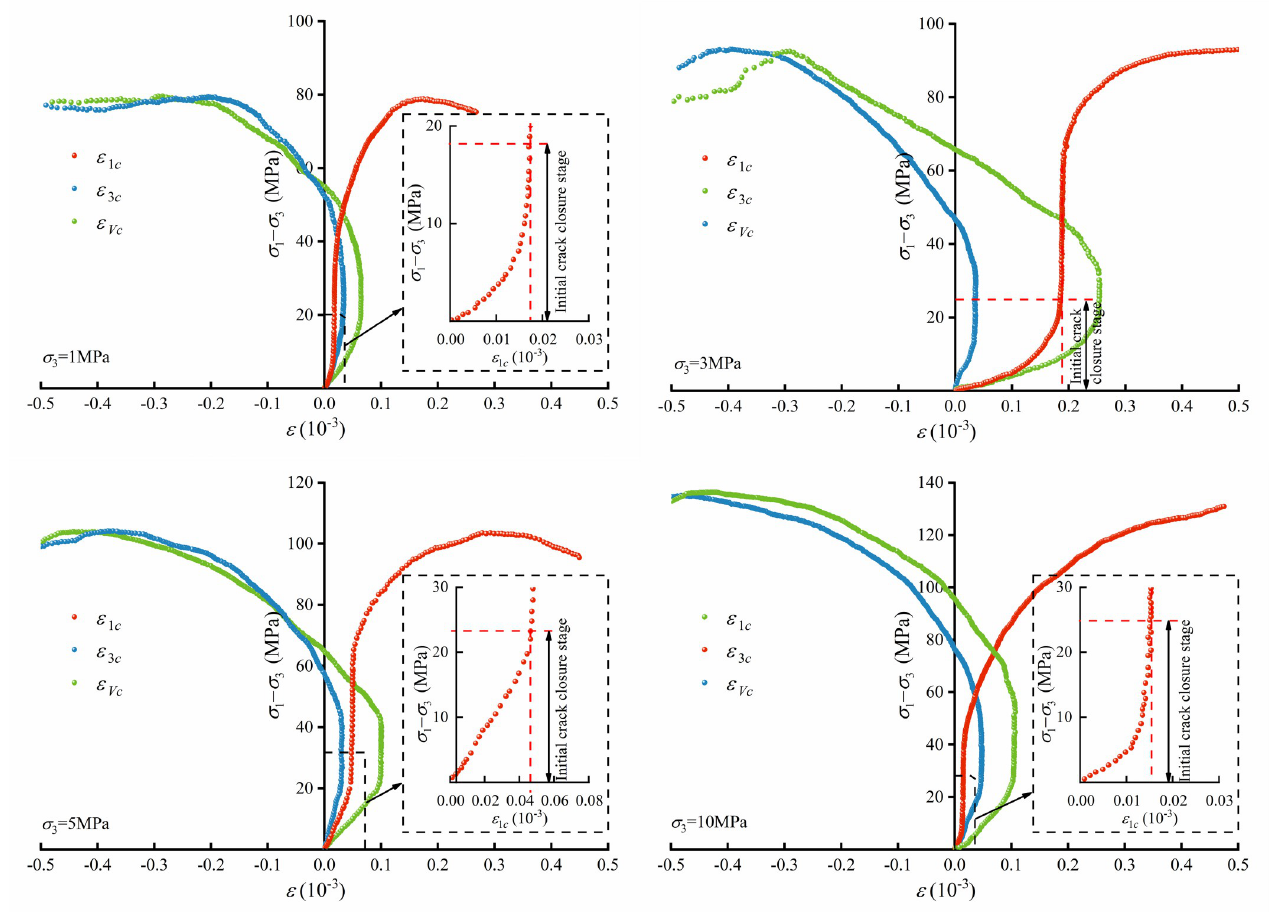
Fig 7. Crack strain and stress thresholds of micritic bioclastic limestone.